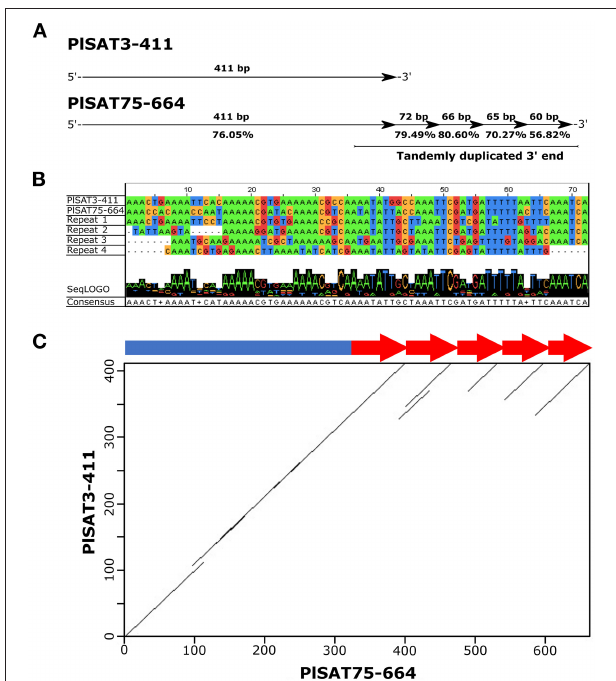
FIGURE 5 | (A) Detailed analysis of satellite family PlSAT75-664 and its similarity with satellite family PlSAT3-411, (B) Alignment of PlSAT75-664 subrepeats visualized within Jalview ( Waterhouse et al., 2009) and (C) Dot plot of the satellite family PlSAT75-664 obtained in the RepeatExplorer analysis of the P. leptodactylus genome, that shows similarity with the satellite family PlSAT3-411 satDNA of P. leptodactylus , revealing subrepeats with a periodicity of about 70 bp